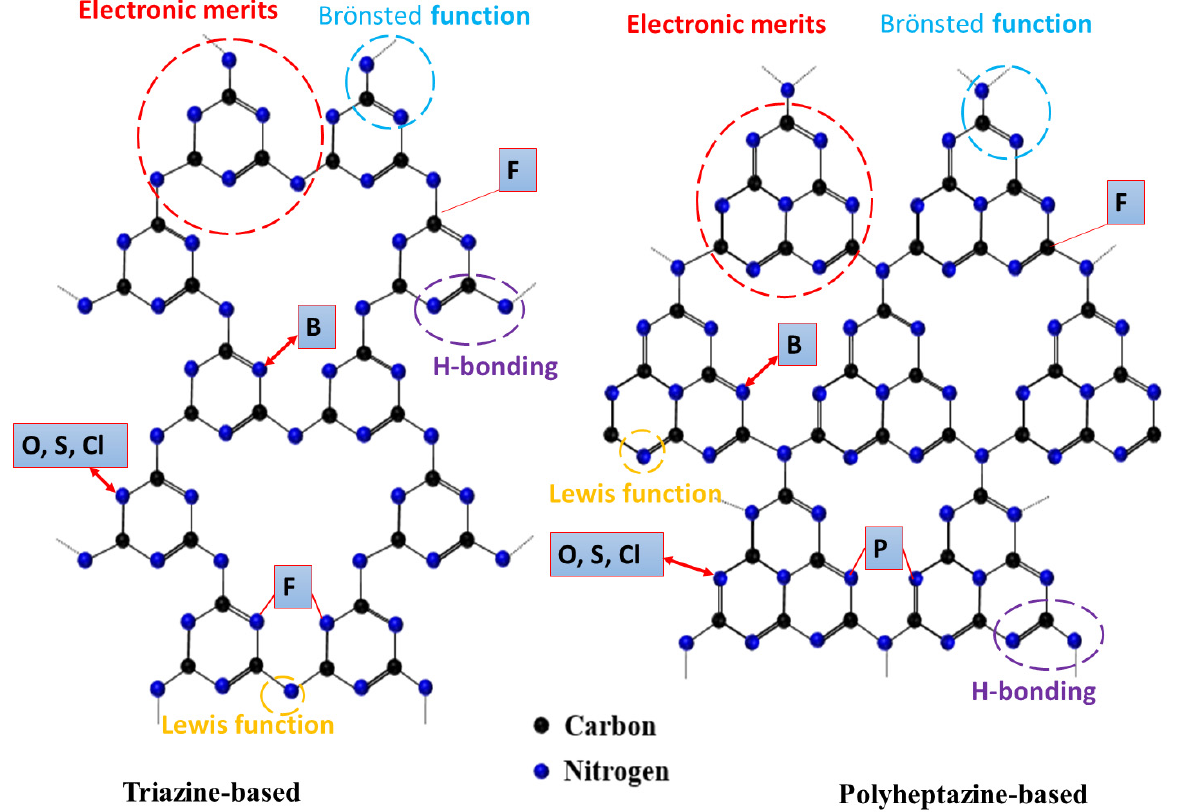
Figure 4. The molecular structures of gCNs and their merits and accommodation sites for non-metal dopants into gCNs based on data from Ref [28,38,64].